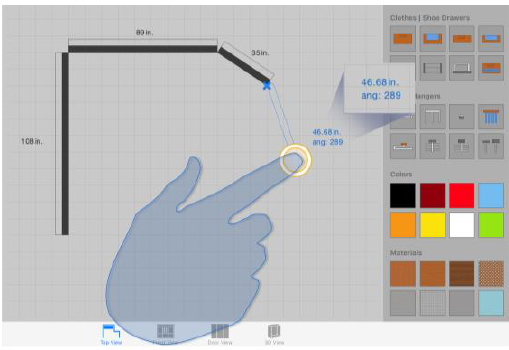
Figure 10. Additional viewport that provides the user in real time with the length of the wall being created